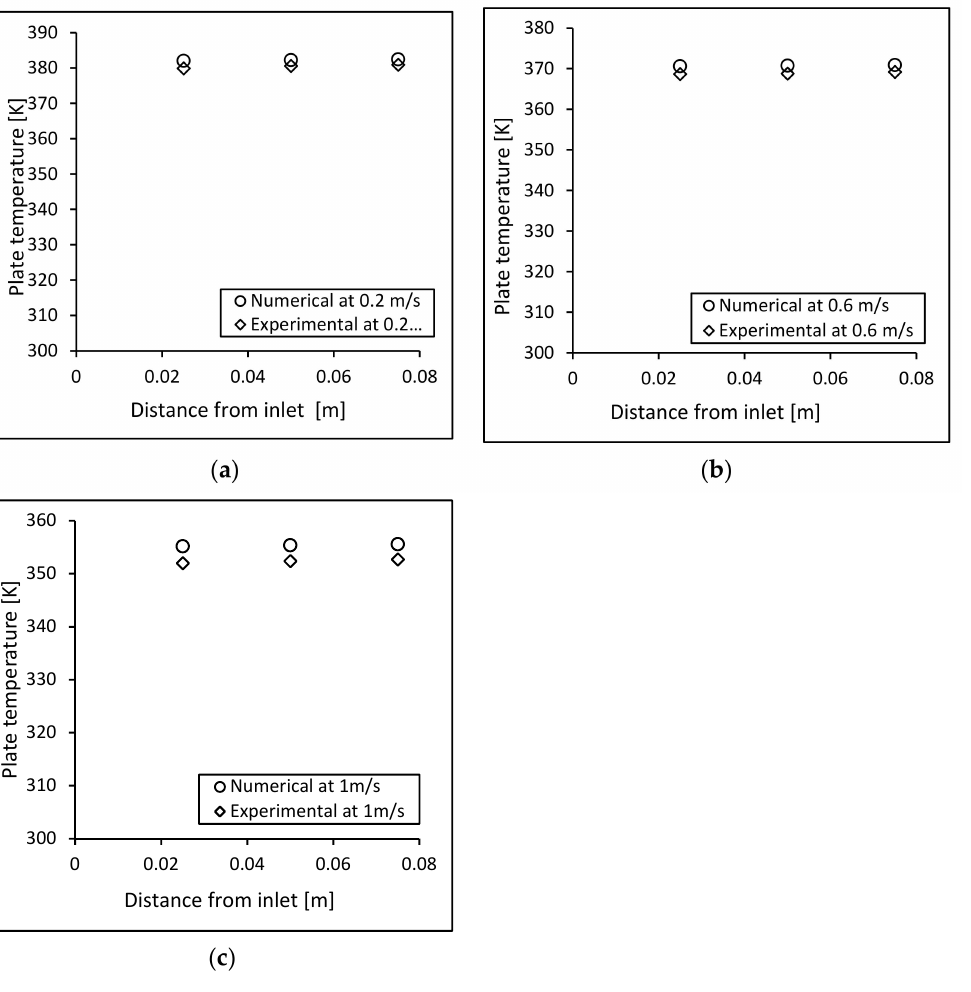
( b ) Figure 13. End plate and internal plate temperatures at different locations in the flow direction: ( a ) for 0.2 m/s; ( b ) for 1.5 m/s. 4.2. Pumping Power The numerical and experimental results of the pressure drop were used to calculate the pumping power. Equation (23) was used to calculate the pumping power: 𝑊(cid:4662) (cid:3404) 𝑄. ∆𝑝 (23) where 𝑊(cid:4662) represents the pumping power in watts needed to pump the air through the cooling system, 𝑄 is the volumetric flow rate across the foam (m 3 /s), and ∆𝑝 is the pres ‐